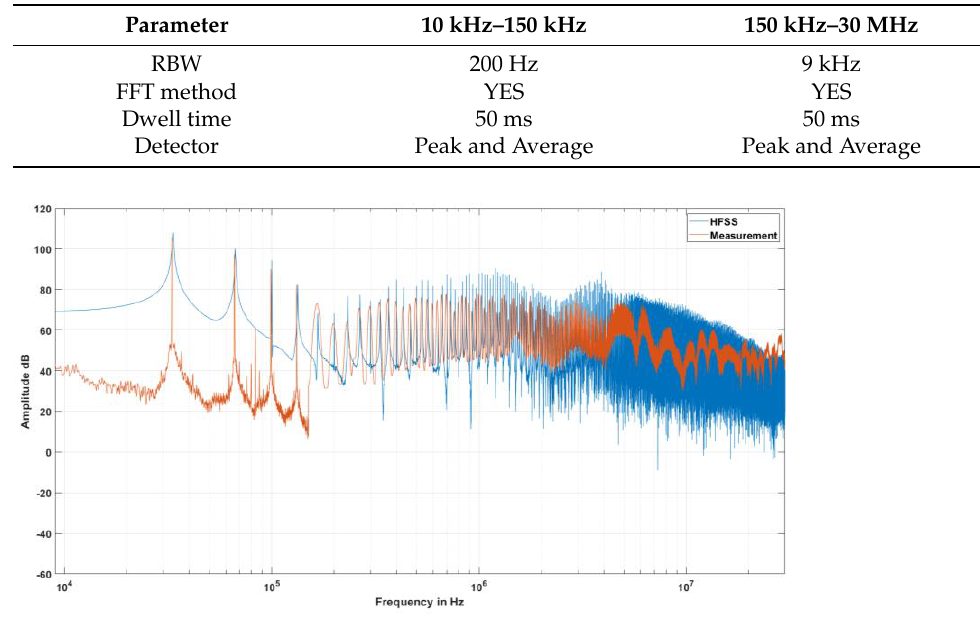
Figure 23. Conducted emission measurement result. EMC32 (Rohde & Schwarz, Germany, Mu- nich) software view. Table 2. Parameters of the measurement set in EMC32 Studio. Table 2. Parameters of the measurement set in EMC32 Studio.